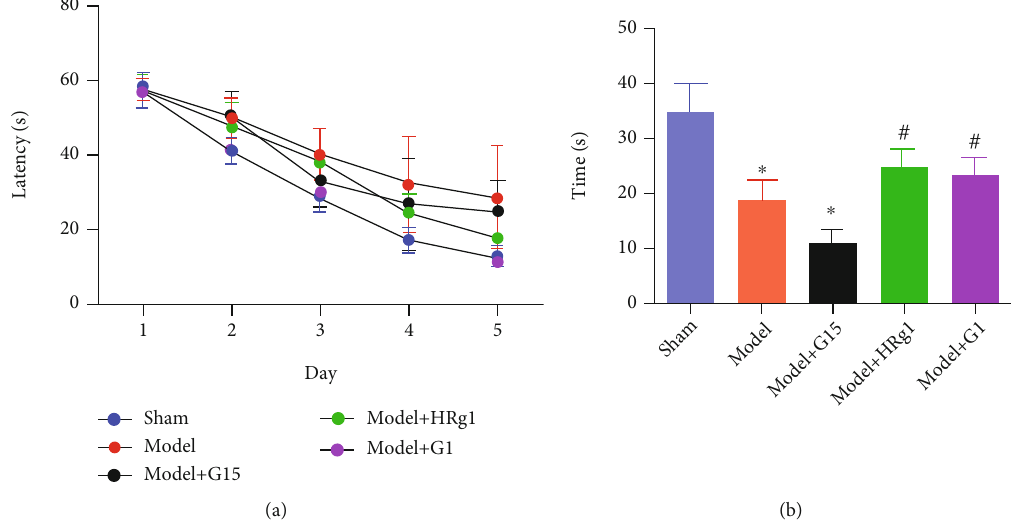
Figure 4: Ginsenoside Rg1 improves memory in BCAS model animals. (a) The latency to fi nd the platform during fi ve-day training. (b) Time spent in target quadrant. ∗ P < 0 : 05 , vs. sham; # P < 0 : 05 , vs. the model group ( N = 5 in each